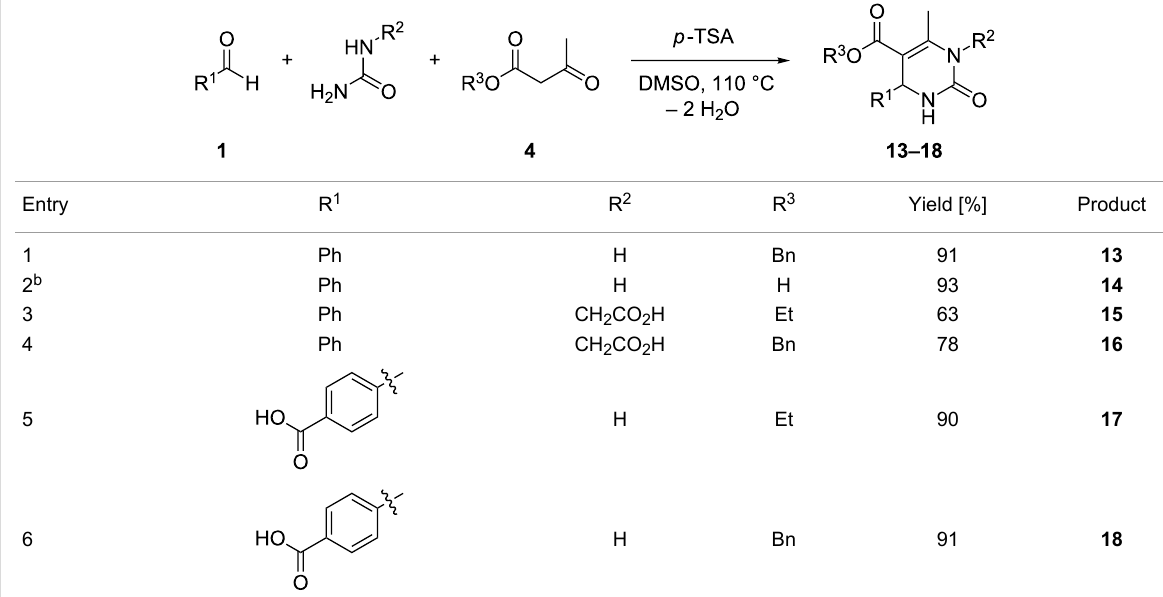
Table 1: Biginelli reactions for the preparation of DHMP acids.